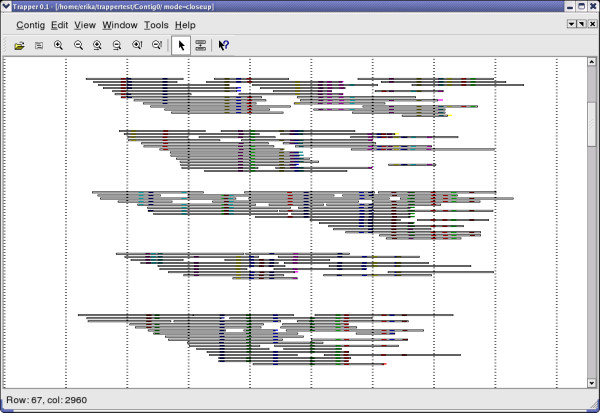
Five of the ten repeat groups in the simulated dataset after automatic sorting and manual correction. Each group consists of reads sampled from one repeat unit in the target sequence respectively. The repeat groups are clearly distinguishable from each other by their DNP patterns.